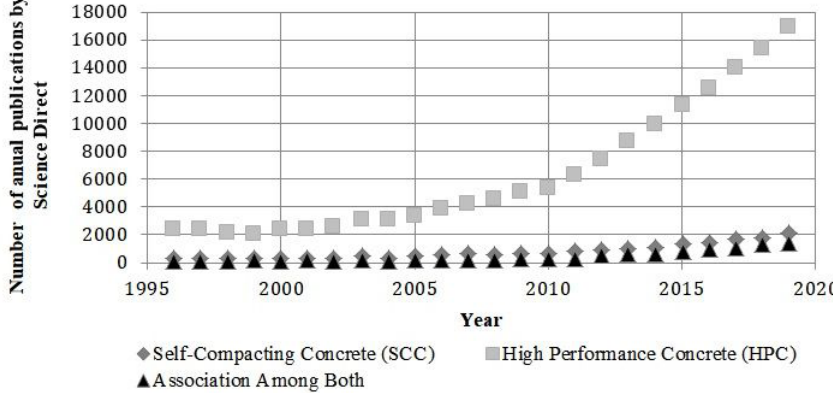
Figure 1. Number of annual publications about SCC, HPC and both in relation to the year by Science Direct.